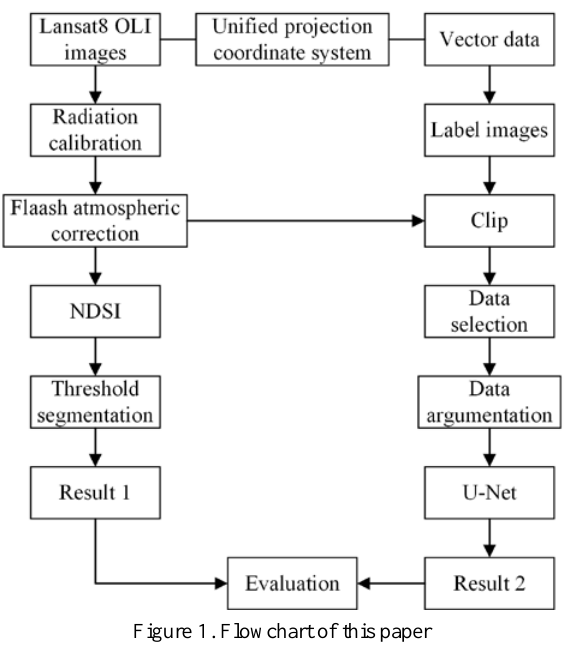
Figure 1. Flowchart of this paper